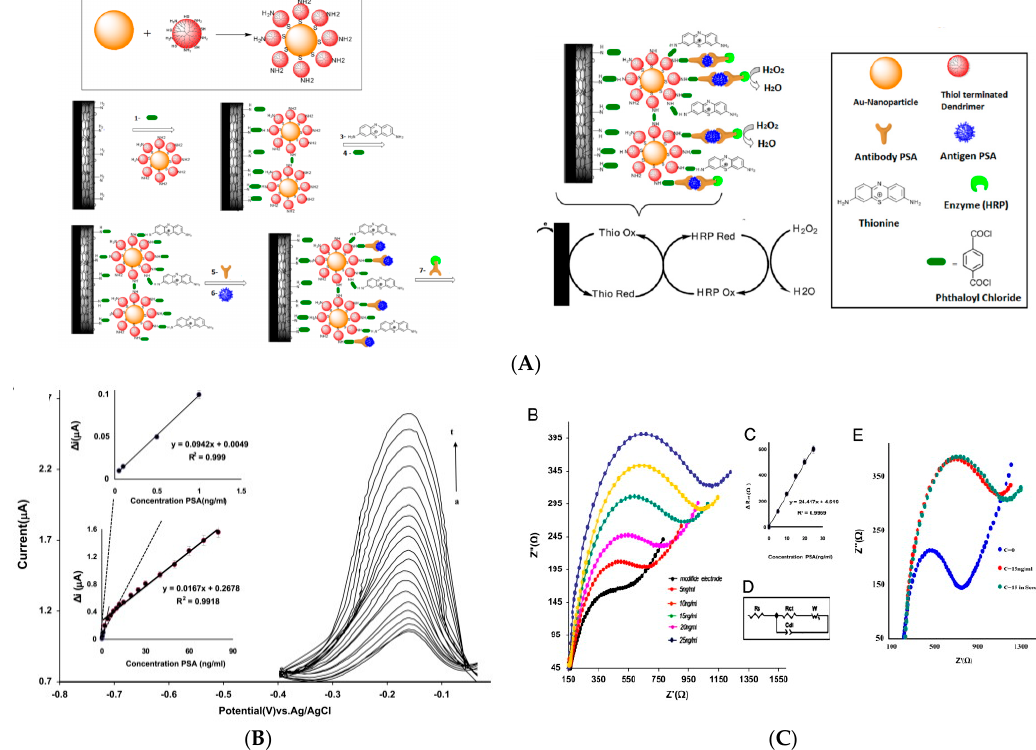
Figure 35. ( A ) PSA immunosensor using AuNPs–PAMAM for signaling and MWCNT/IL/CS as substrate, and transduction with HRP and thionine as immobilized mediator. ( B ) CVs of the immunosensor after incubation with PSA from O up to 80 ng mL − 1 in PBS, pH 7 + 2.5 mM H 2 O 2 . Insets, plots of the immunosensor response vs. PSA concentrations. ( C ) Nyquist curves for 2.5 mM [Fe(CN) 6 ] 3 − /4 − in 0.1 M KCl recorded at anti-PSA/AuNPs–PAMAM-dendrimer/MWCNTs/IL/Chit/GC after incubation with 5, 10, 15, 20 and 25 ng mL − 1 PSA. Insets are plot of R ct vs. PSA concentration and the equivalent circuit used to fit the experimental impedance data. On the right, Nyquist curves for the immunosensor in the presence of 15 ng mL − 1 PSA and in serum spiked with 15 ng mL − 1 PSA. Adapted from [176], Copyright 2014, with permission from Elsevier.